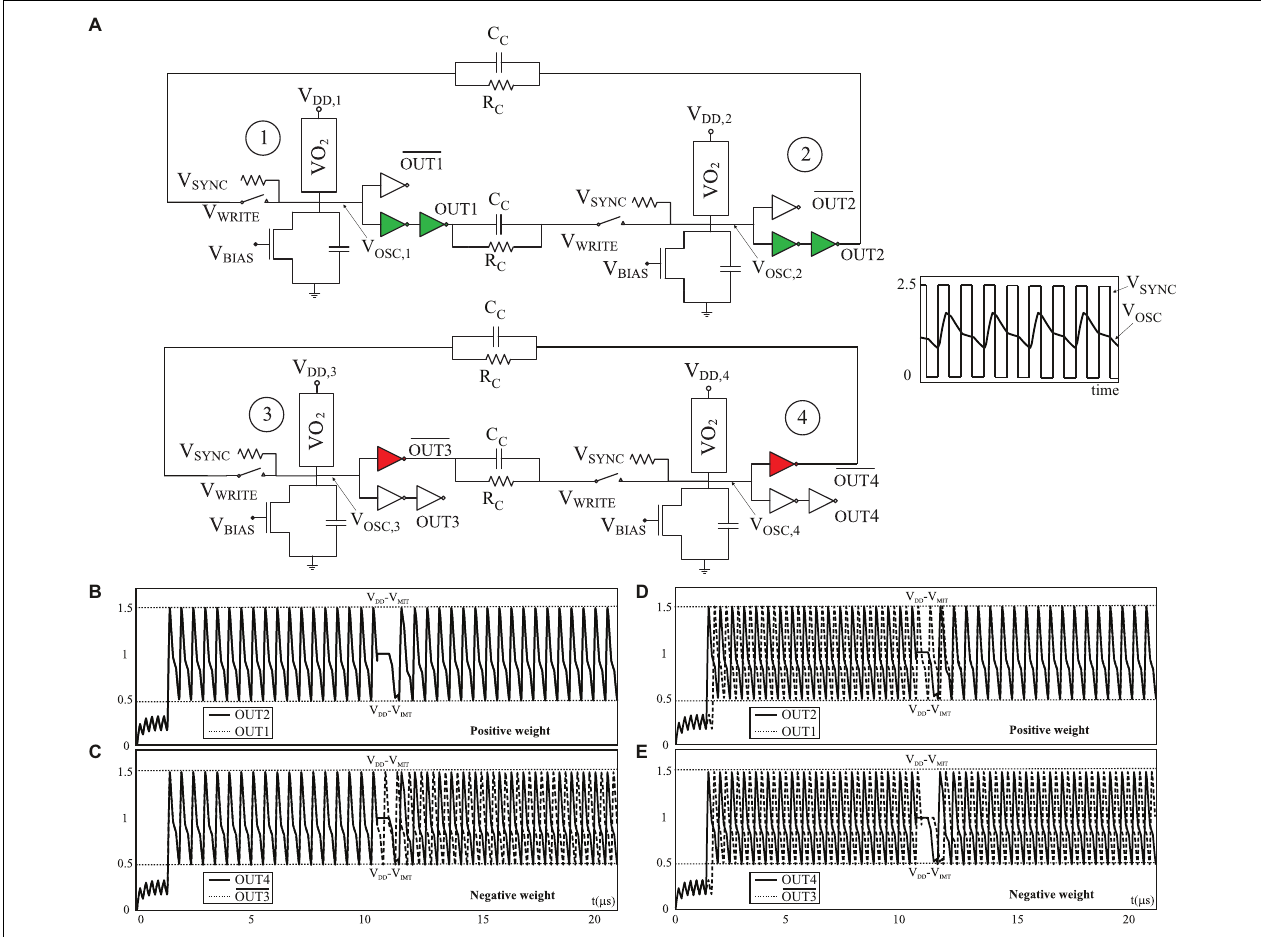
FIGURE 6 | (A) Schematics of the interconnection of two neurons with a positive (green) and a negative (red) weight. (B–E) Waveforms showing the operation of both interconnection schemes.